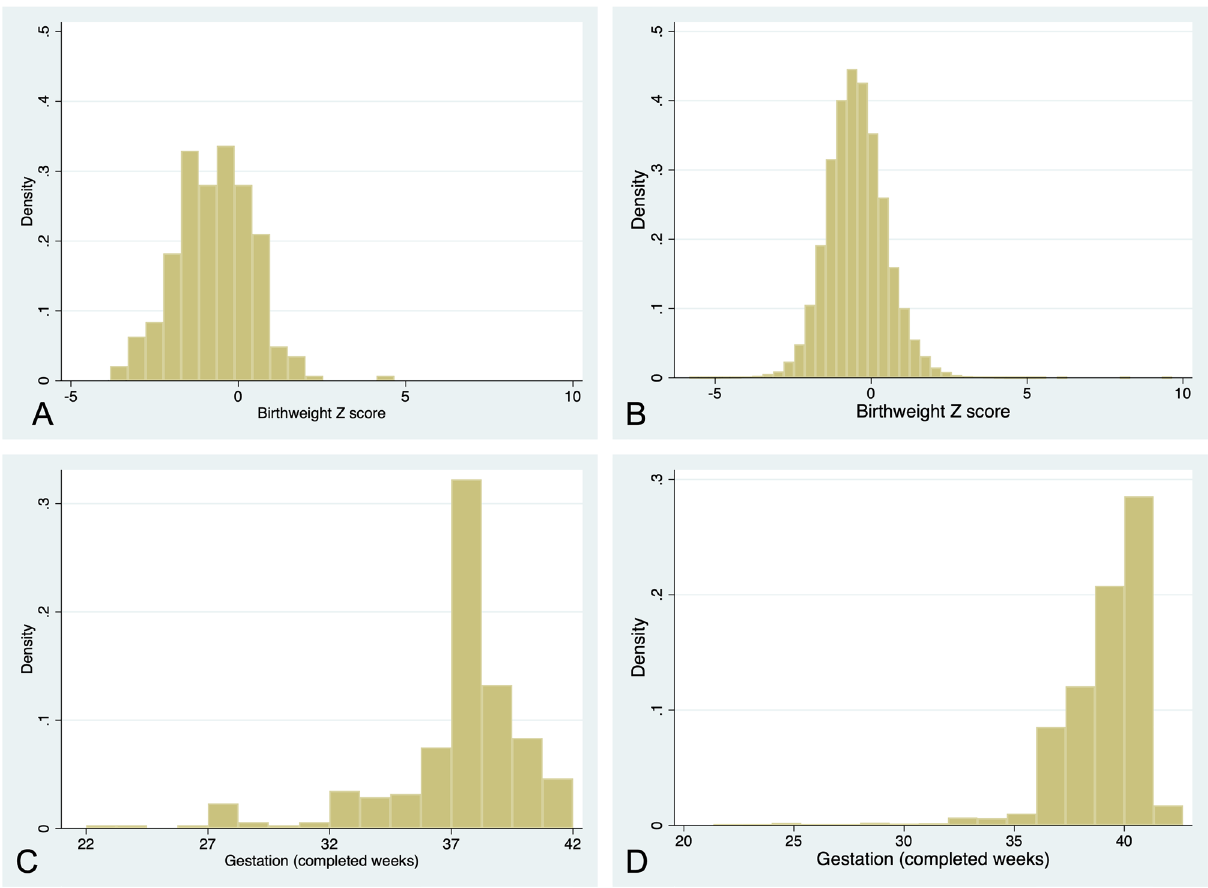
Figure 2. Histograms of ( A ) birthweight Z score in this cohort; ( B ) birthweight Z score in the background population; ( C ) gestation at delivery (completed weeks) in this cohort; and ( D ) gestation at delivery (completed weeks) in the background population. Background population distributions were derived from 5-year data (2016–2020) from St Mary’s Hospital, Manchester, associated with earlier gestation at delivery (log-transformed difference: -0.10 days [95% C.I. − 0.18 to − 0.03], p = 0.01) and tricuspid annular plane systolic excursion (TAPSE; a measure of right ventricular function) which weakly correlated with birthweight z score (coefficient: 0.04 [95% C.I. 0.00–0.08]). Pre-eclampsia prevalence was not associated with any antenatal medication. SGA and FGR were more preva- lent in women taking ß blockers antenatally (SGA: 49/127 [38.6%] vs. 37/138 [26.8%], p = 0.04; FGR: 28/127 [22.0%] vs. 13/138 [9.4%], p = 0.005). Antenatal exposure to heparin was associated with a higher prevalence of FGR (16/65 [24.6%] vs. 22/196 [11.2%], p = 0.008). The relationship between heparin and birthweight Z score was lost after adjustment for pre-existing hypertension, underlying cardiac diagnosis and LV impairment sever- ity (adjusted difference: − 0.29 [95% C.I. − 0.61–0.04], p = 0.09). Antenatal ß blocker use was associated with lower birthweight Z score, even after adjustment for pre-existing hypertension, underlying cardiac diagnosis and severity of LV impairment (adjusted difference − 0.31 [95% C.I. − 0.61 to − 0.01], p = 0.04). Furthermore, this relationship persisted after adjustment for smoking (adjusted difference − 0.38 [95% C.I. − 0.67 to − 0.09], with those who were known to take alternative ß blockers (n = 17) demonstrated no difference (difference 1.12 [95% C.I. − 0.42–2.68], p = 0.15). The association between antenatal ß blockers and earlier gestation at delivery was lost after adjustment for LVEF (adjusted log-transformed difference: − 0.02 [95% C.I. − 0.04–0.00], p = 0.09). Supplementary Table S9 compares maternal characteristics between those exposed to ß blockers antenatally and those not.